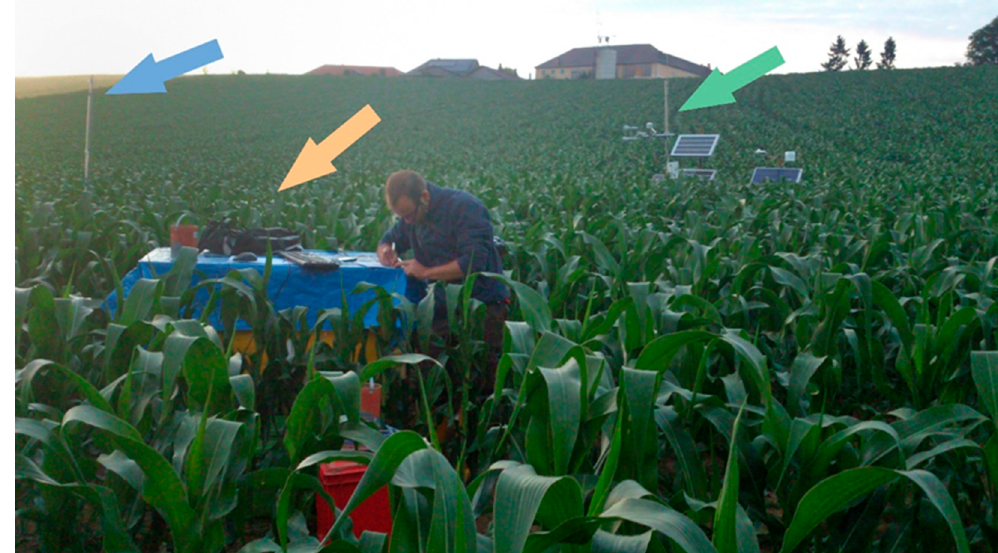
Figure 1. Experimental setup for the field campaign, showing the location of the measurement profile pole (blue arrow), the Picarro isotope analyzer (orange arrow, under blue tarp), and the eddy covariance station (green arrow).